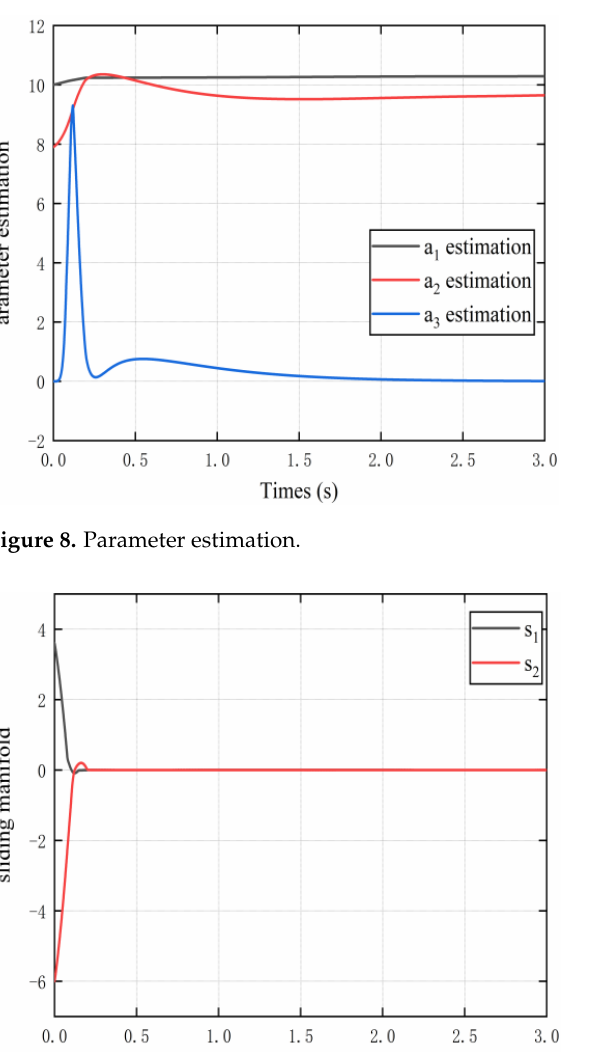
Figure 7. Position tracking error and velocity tracking error of Joint 1 and Joint 2.